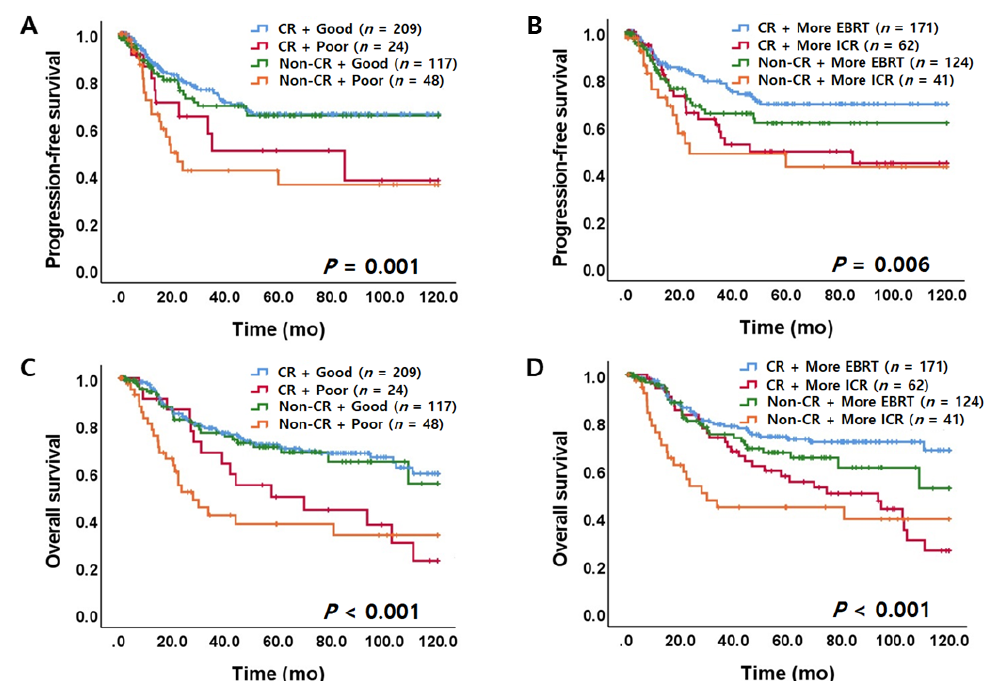
Figure 3. Long-term survival outcomes when incorporating early response and overall response to RT.